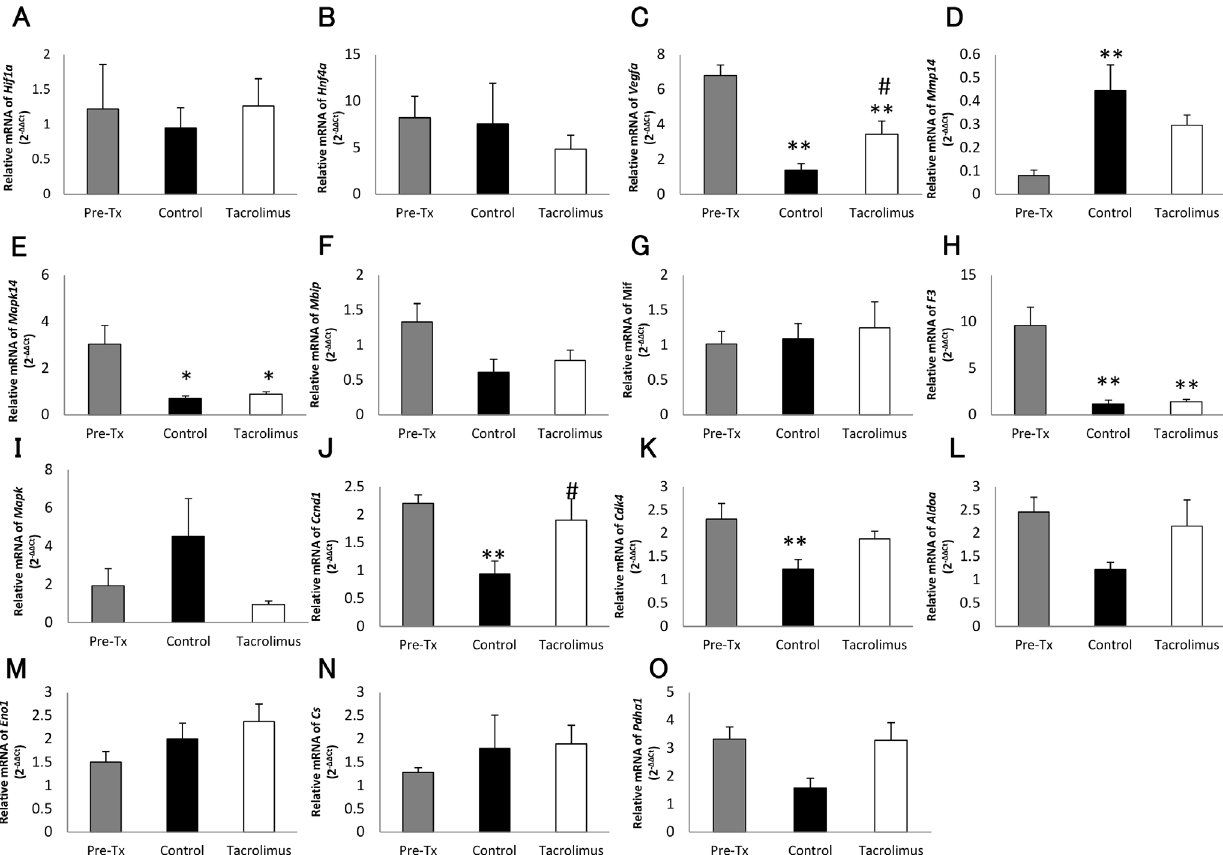
Figure 7. Relative gene expression in the transplanted pancreatic islets with and without tacrolimus. Relative gene expression of Hif1a (A), Hnf4a (B), Vegfa (C), Mmp14 (D), Mapk (E), Mbip (F), Mif (G), F3 (H), Il1b (I), Ccnd1 (J), Cdk4 (K), AldoA (L), Eno1 (M), Cs (N), and Pdha1 (O) in islets before transplantation (gray bar), the control group (black bar), and the tacrolimus-treated group (white bar). The values in the control and tacrolimus treated-group were represented as the ratio to the values in islets before transplantation. *P , 0.05 in comparison to the islets before transplantation, **P , 0.01 in comparison to the islets before transplantation, and # P , 0.05 in comparison to the control group.